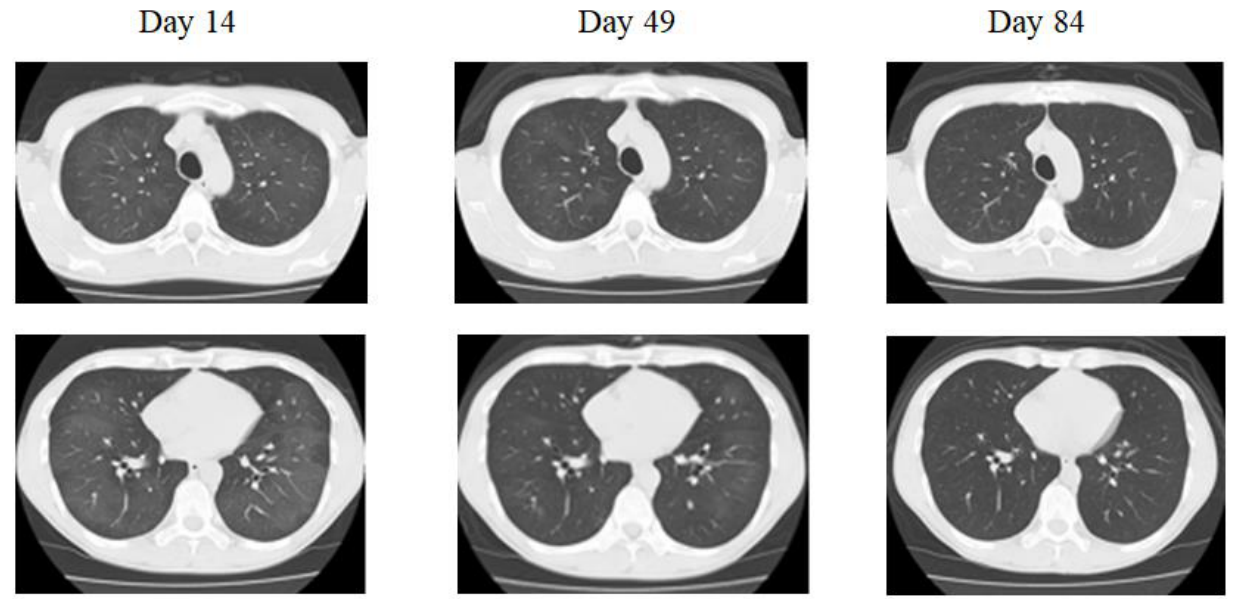
Figure 1. Chest X-ray and chest computed tomography (CT) in case 1. Bilateral diffuse, ground-glass opacity can be observed, but no pleural nadir shadow. A mosaic pattern can be observed in some areas (Day 14). There is a trend toward shadow reduction in both the upper and lower lung fields, but shadows are still present (Day 49). Improved completely (Day